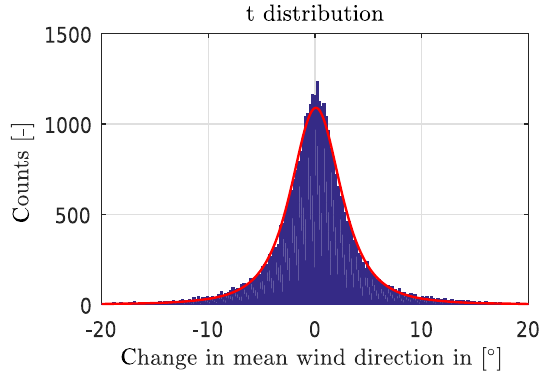
Figure 13. Histogram of the changes of the mean values of succes- sive wind direction time series (cid:49)(cid:56) t with a fitted t